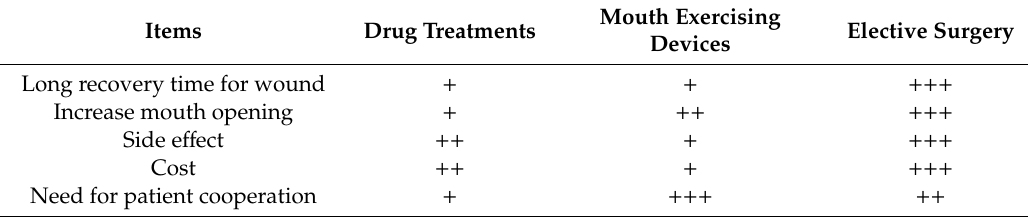
Table 6. Comparison of di ff erent treatment methods for